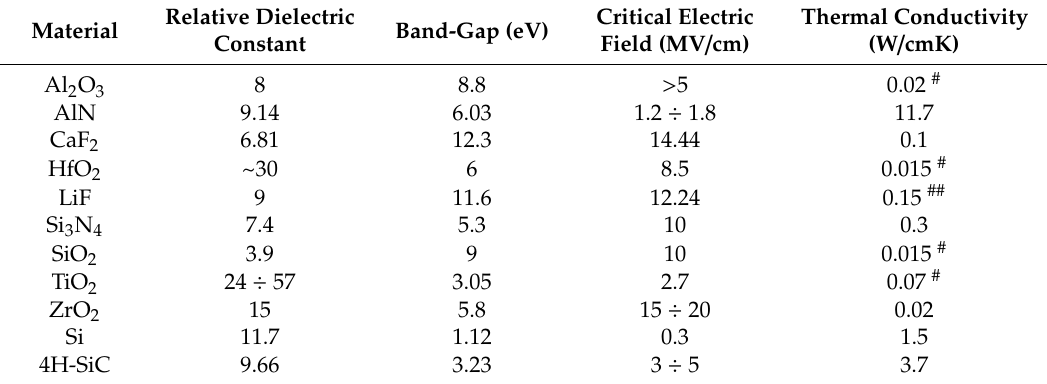
Table 2. Dielectric constant, band-gap and critical electric field for several dielectric materials with Si and 4H-SiC as references. Table adapted from